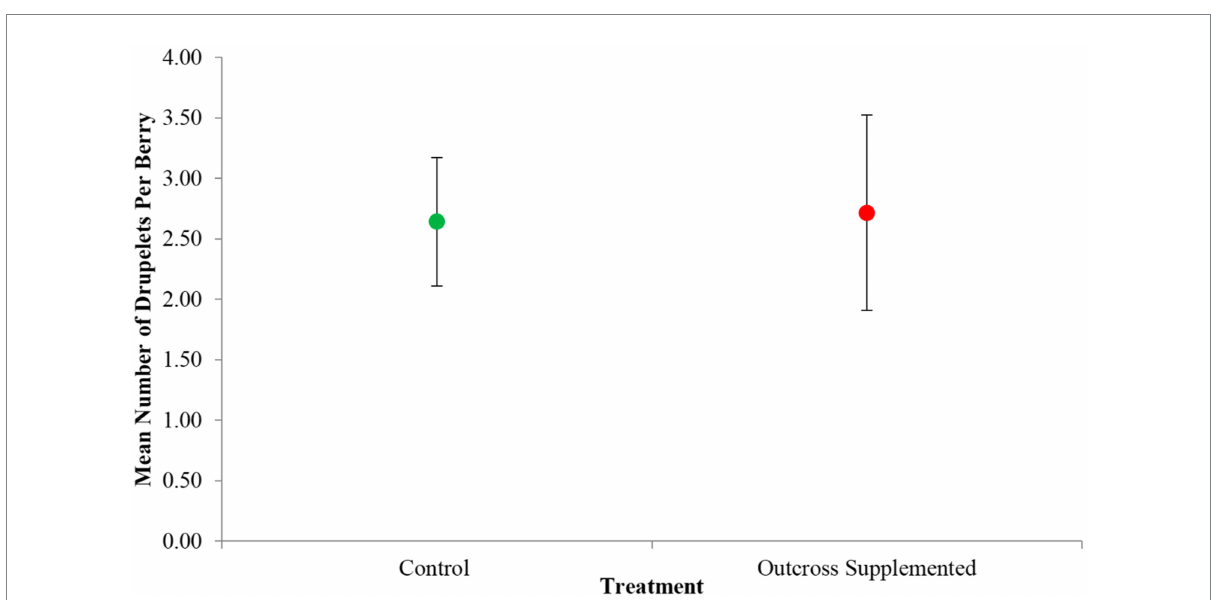
FIGURE 3 The mean number of drupelets per berry for the control ( N = 14) and outcross supplemented ( N = 7) treatment groups in the pollination supplementation experiment. Error bars represent standard